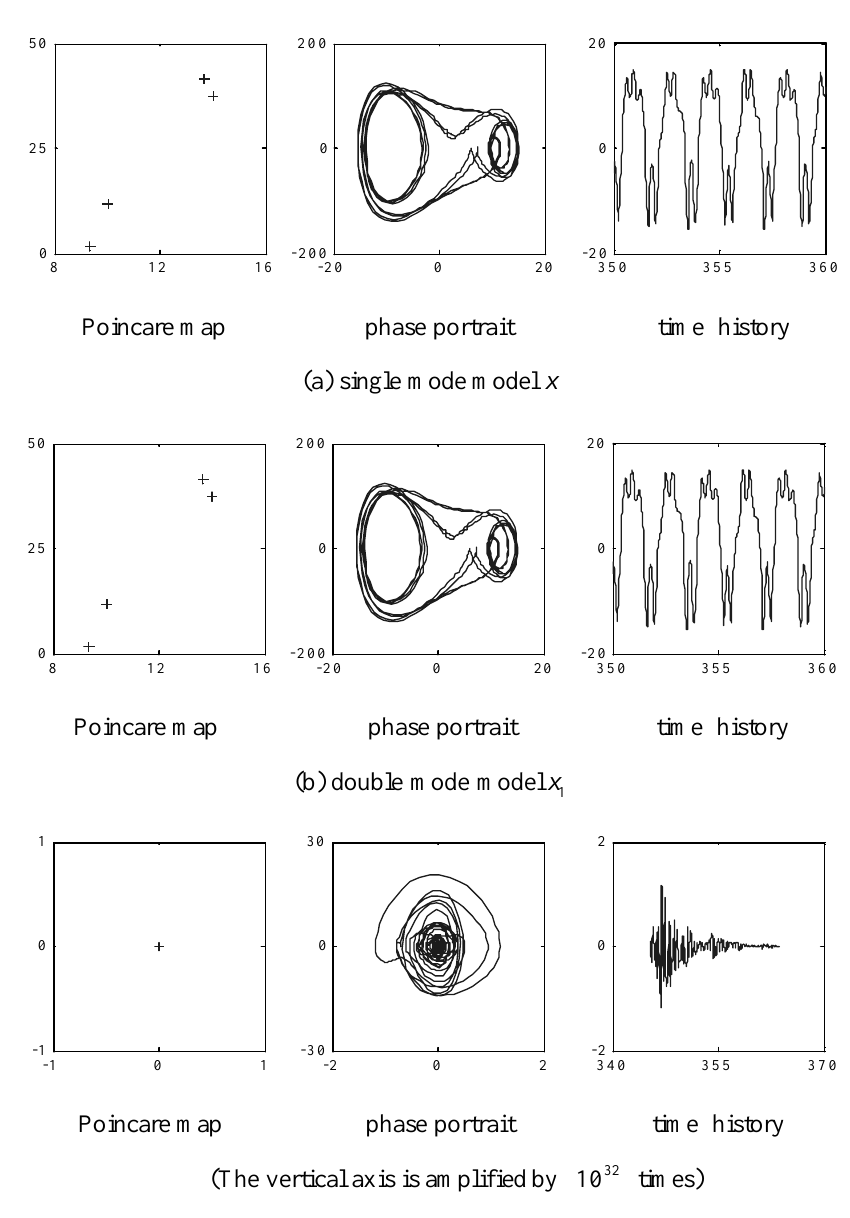
Fig. 5. Comparison between single and double mode models ( ω = 1 . 1 π , g = 1400